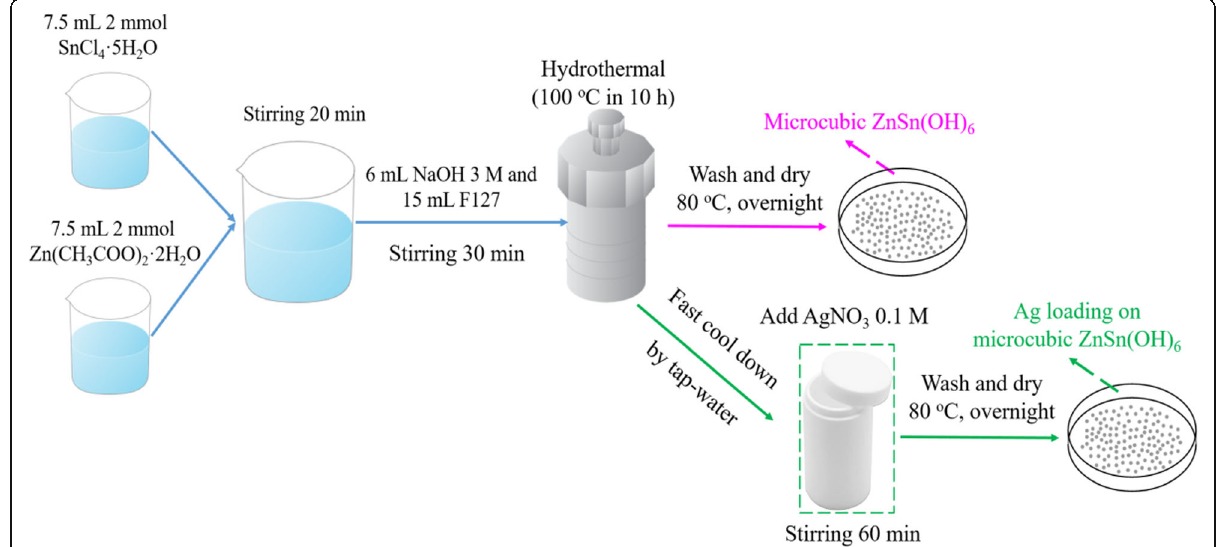
Fig. 1 The synthesis process of cZHS and